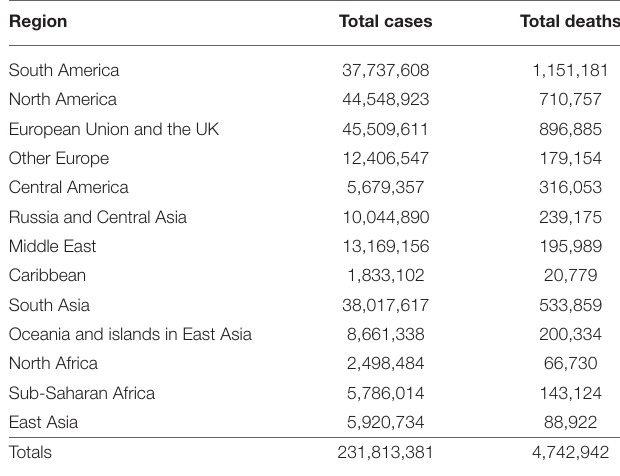
TABLE 1 | COVID-19 cases and fatalities by region (Dhama et al., 2020, see text footnote 4).